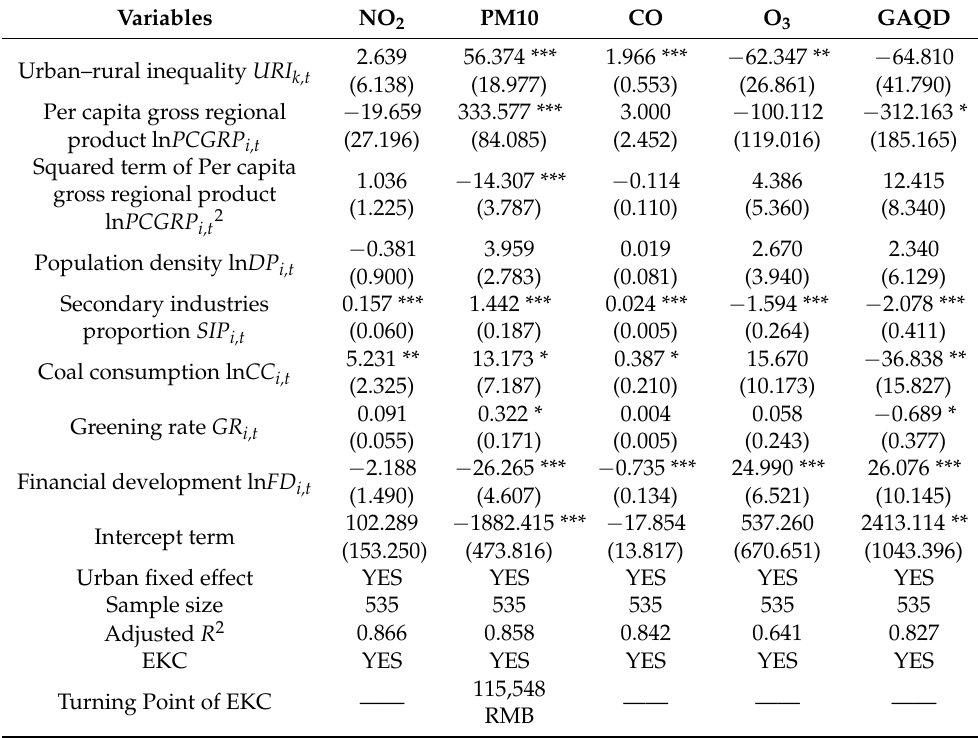
Table 7. Regression analysis for EKC hypothesis: other air